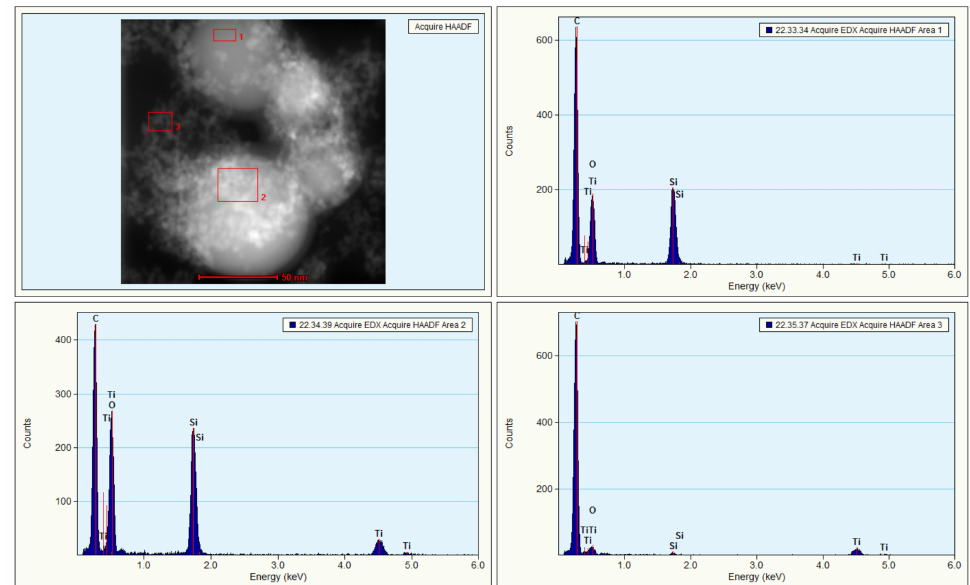
Figure7. STEM-EDXareascansofSampleATiO 2 -NP / SiO 2 -colloidagglomeratesatpH8. Thethreeareas marked in red of the area scans depict (1) Si and O, (2) Ti and O and (3) Si, Ti and O signals respectively.